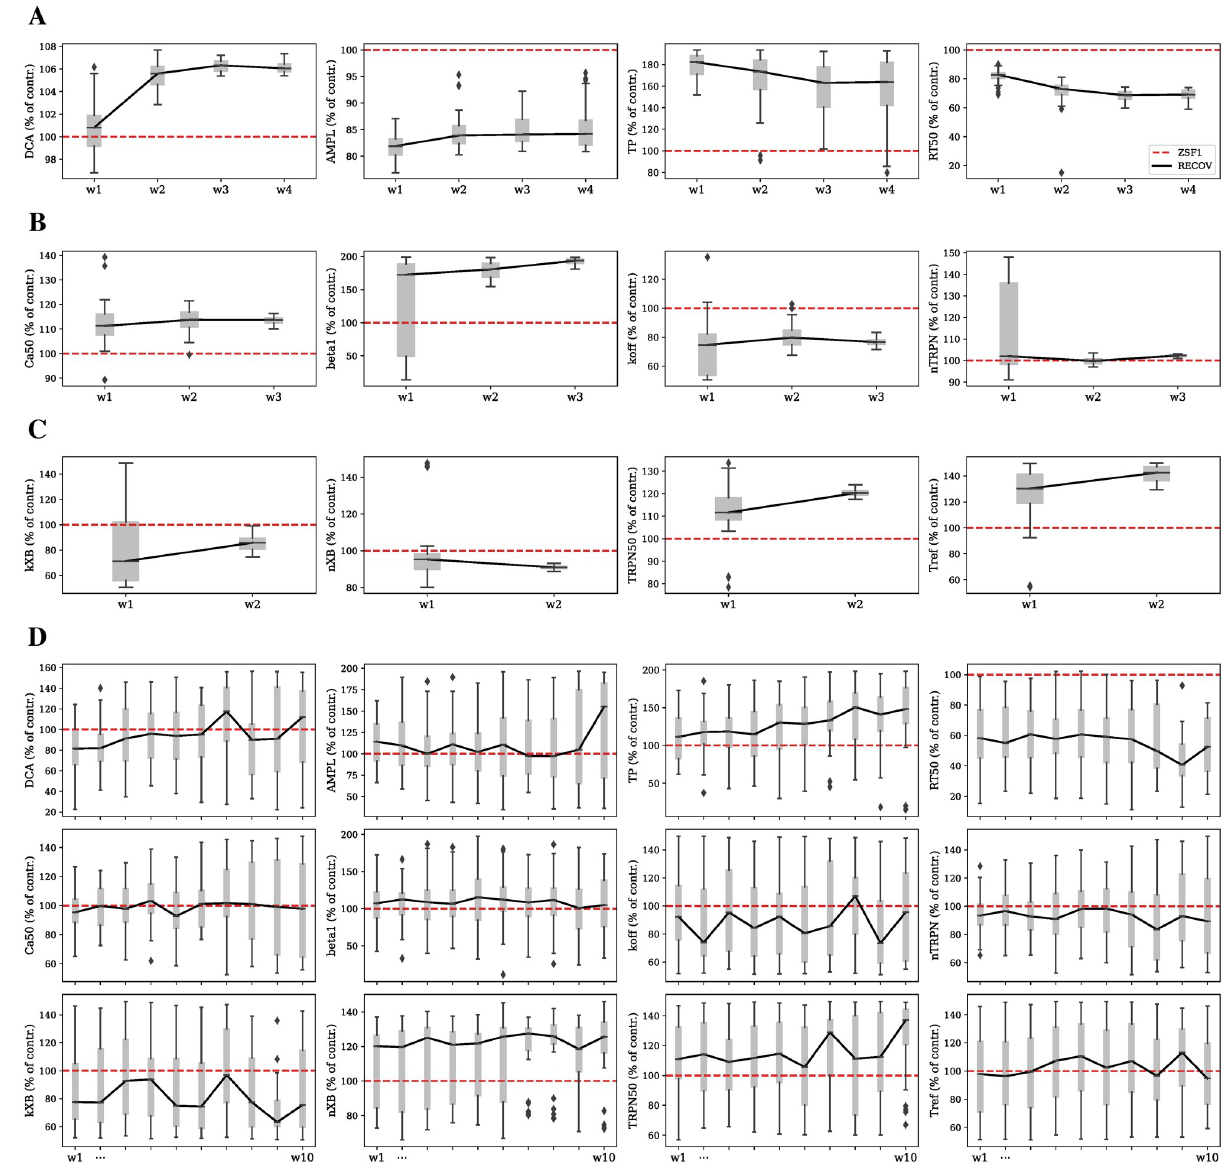
Fig 8. Parameter distributions across progressing waves for the four different parameter groups. Each parameter distribution is represented as a gray box plot at each wave. Its median trend during multiple waves is highlighted in a solid black line and is compared with the ZSF1 rat model reference value for the same parameter highlighted in a dashed red line. All the plotted RECOV parameter values are given as percentages of the respective baseline ZSF1 parameter values. (A) Ca group. (B) TNF group. (C) TKF group. (D) CaMYO group.